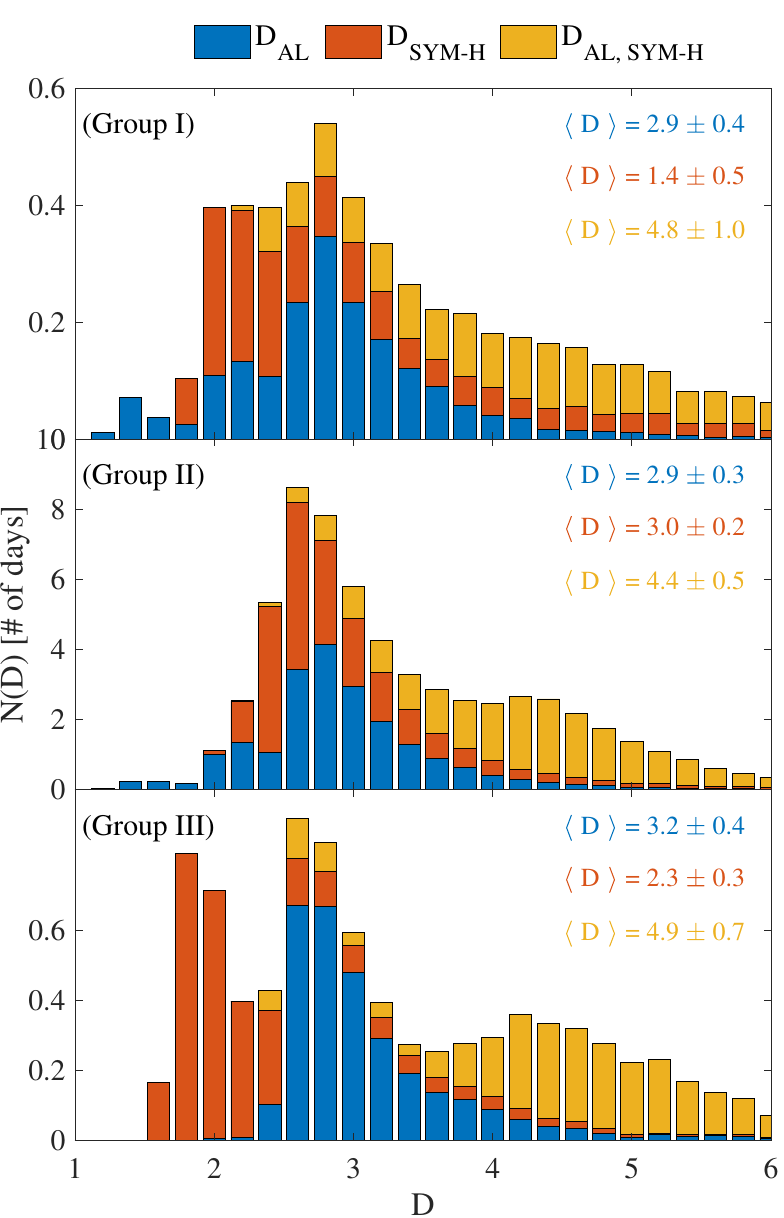
Figure 7. Histograms of the instantaneous dimensions D as a function of the different geomag- netic activity levels: Group I (SYM-H > 10 nT), Group II ( − 20 nT ≤ SYM-H ≤ 10 nT), Group III (SYM-H ≤ − 50 nT). Blue, orange, and yellow bars refer to D AL , D SYM − H , and D AL , SYM − H , respec- tively. The average values and their uncertainties are reported in each panel for each D . The values of D have been grouped into equidistant bins of size